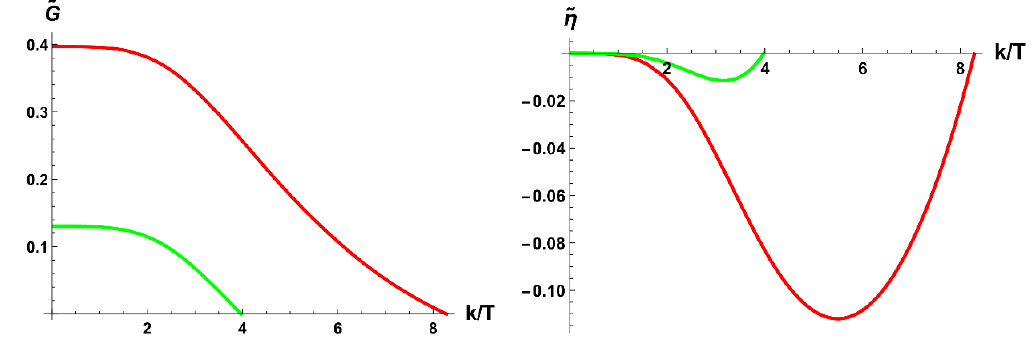
(cid:8) 1 (cid:9) = ; 1 , (cid:22) 12 6